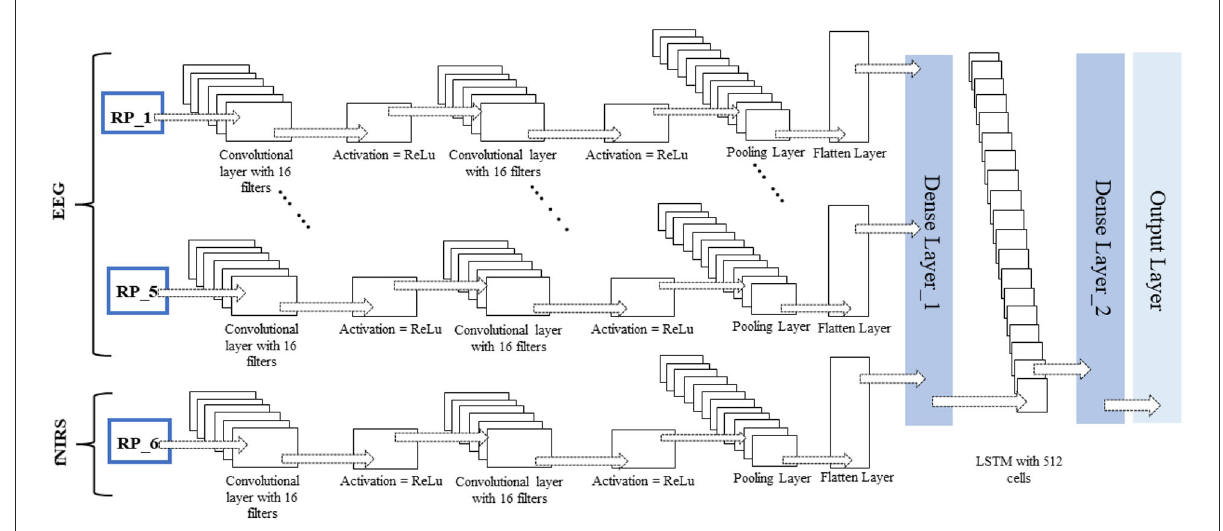
FIGURE7 Time-distributed CNN-LSTM network for classification of four-class mental workload using RPs of hybrid EEG-fNIRS dataset.